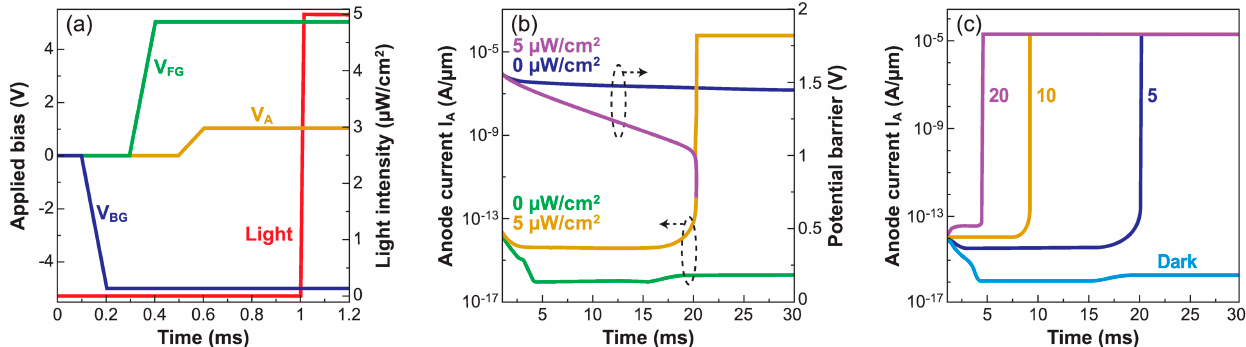
Figure 20. ( a ) Bias and light waveforms in a Z 2 –FET photo-detector. ( b ) Time-dependent evolution of the potential barrier at anode and Z 2 –FET current with and without exposure to light at t = 1 ms. ( c ) Anode current as a function of time during exposure to light (adapted from [54]).